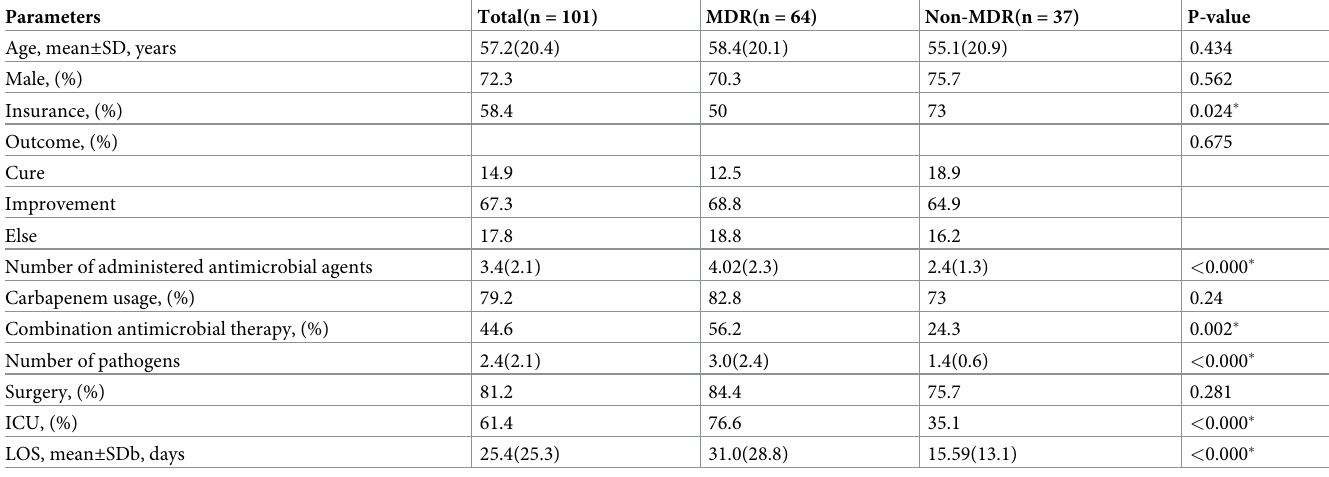
Table 1. Characteristics among patients with intra-abdominal